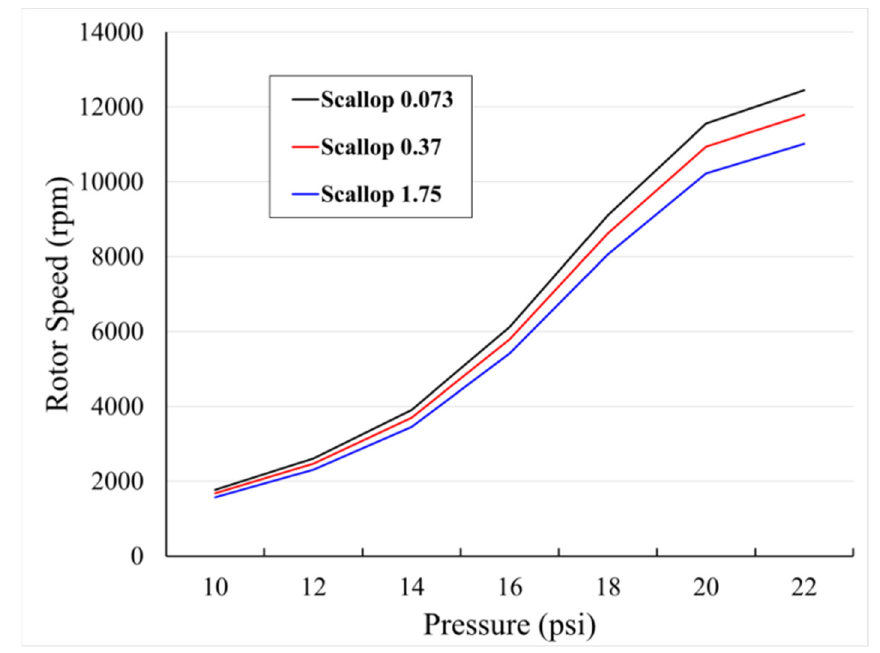
Figure 9. Measured rotor speed curve according to the different scallop size.